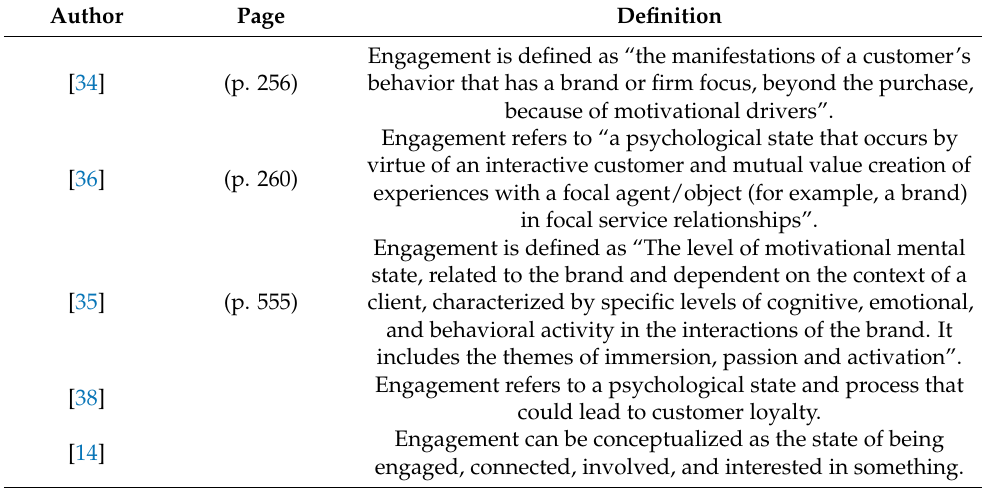
Table 1. Definitions and evolution of the consumer engagement